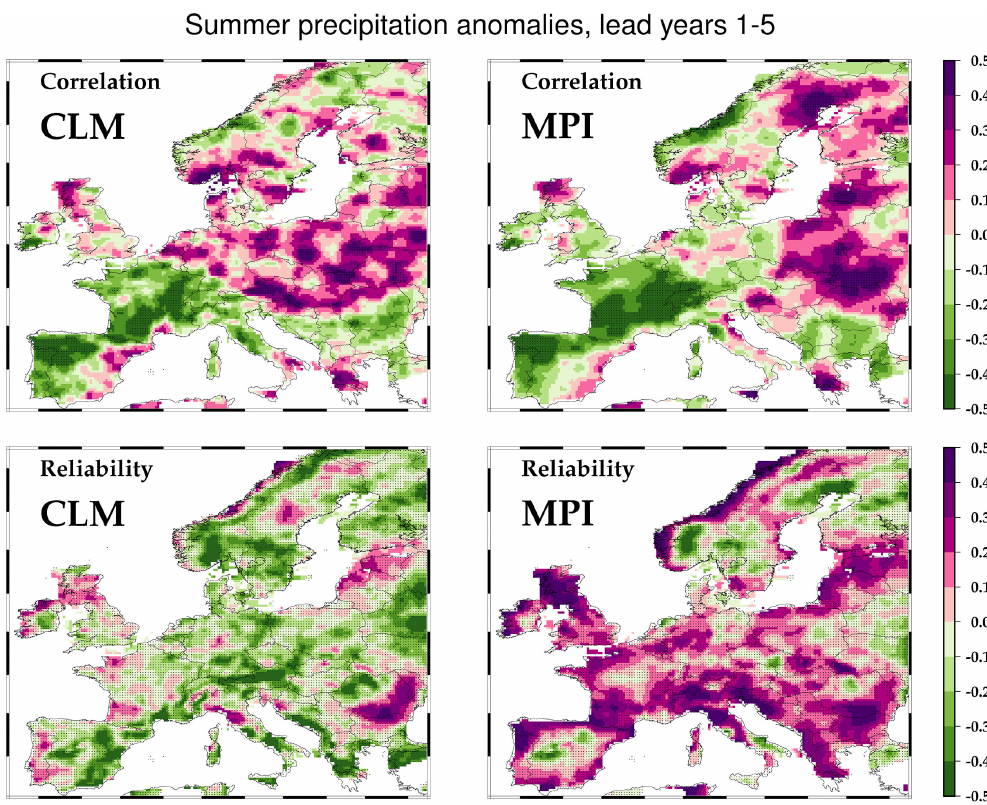
Figure 4. Summer half-year precipitation anomaly sums for lead years 1–5 from 1961 to 2010. The top panels show the correlation coefficient between E-OBS observations and CCLM (left) and MPI-ESM-LR (right). The bottom panels show the reliability of the CCLM (left) and MPI-ESM-LR (right) ensembles with respect to the E-OBS observations. Stippling indicates results, significant at the 10% level.